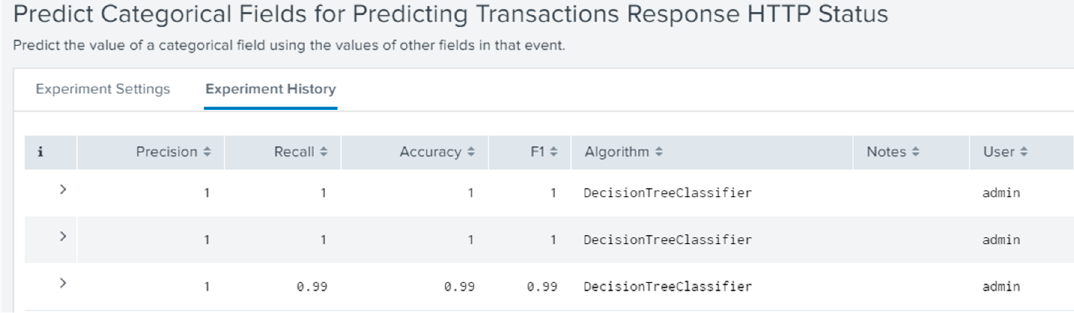
Figure 2. Accuracy after three conducted model evaluations in Splunk Machine learning Toolkit.